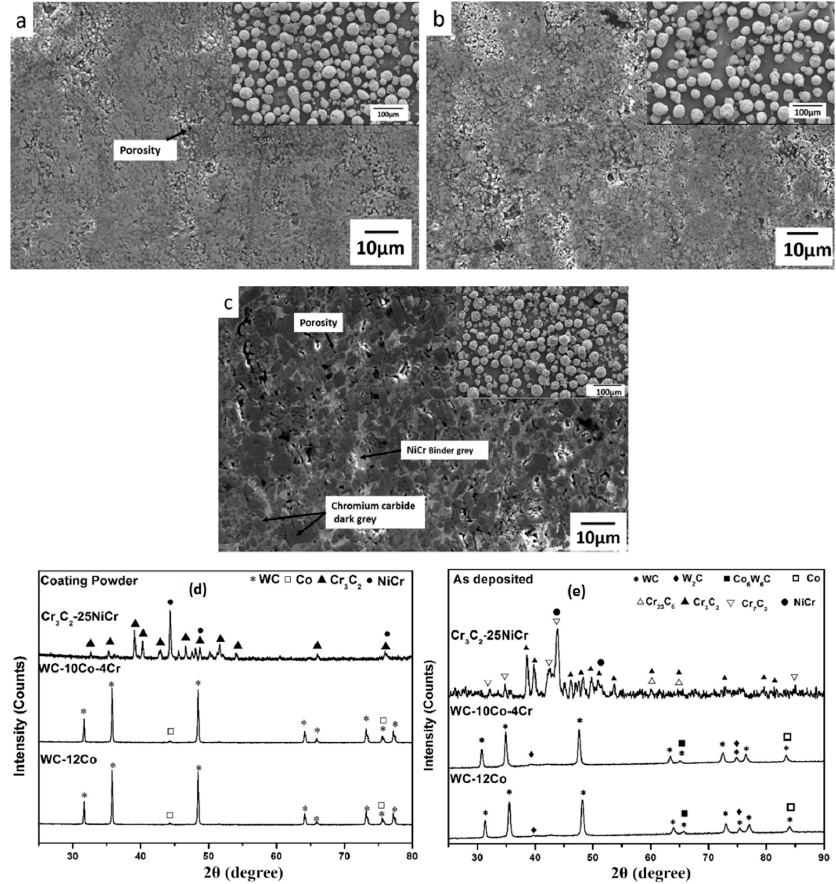
Figure 1. SEM micrographs of the coatings ( a ) WC-12Co, ( b ) WC-10Co-4Cr, and ( c ) Cr 3 C 2 – NiCr and XRD patterns of ( d ) initial feedstock powders and ( e ) as sprayed coatings. In the inset, SEM images of feedstock powders are shown [41] . Reprinted with permission from ref [41]. © 2017 Elsevier.